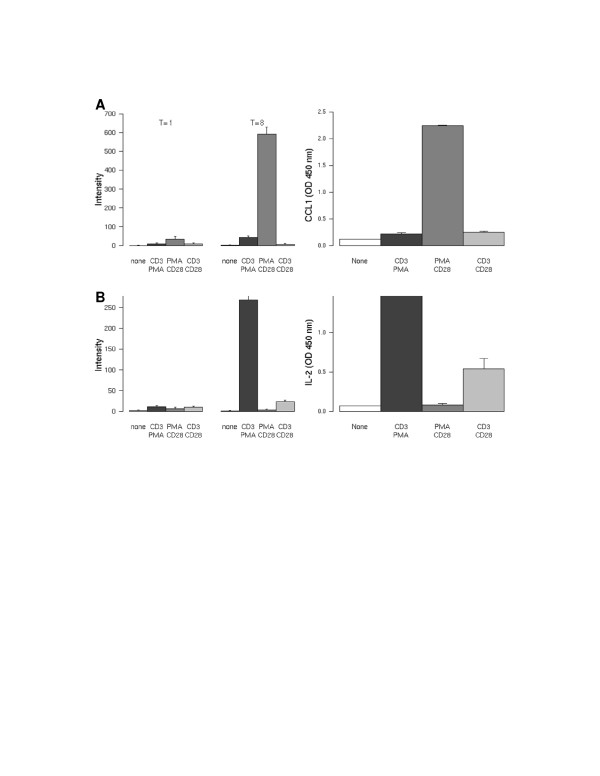
Differential regulation of IL-2 and CCL1. Jurkat T cells were activated for 1 and 8 hours using different stimuli (as indicated). Differentially regulated genes of which the proteins were secreted were identified and the highest ranking genes were selected. A; regulation of the CCL1 mRNA is highly and differentially regulated after PMA/CD28 stimulation. Right panel shows the validation of the mRNA levels on protein level, secreted by activated Jurkat T cells. B; regulation of IL-2 mRNA is highly and differentially regulated after CD3/28 and PMA/CD3 stimulation. Right panel shows the validation of the mRNA levels on protein, secreted by activated Jurkat T cells.